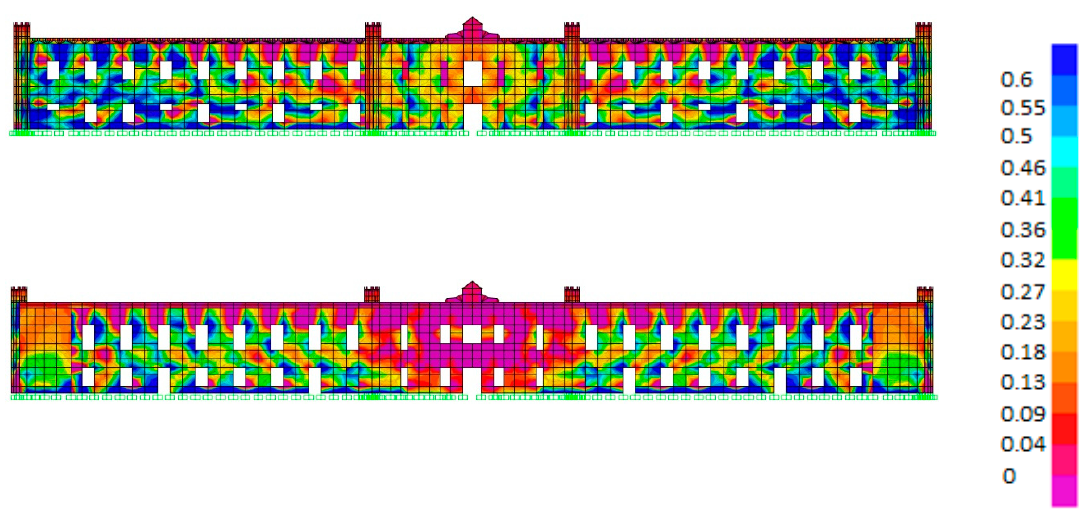
Figure 20. Map of the major principal stresses (MPa) from the linear sequential model, front and rear views.